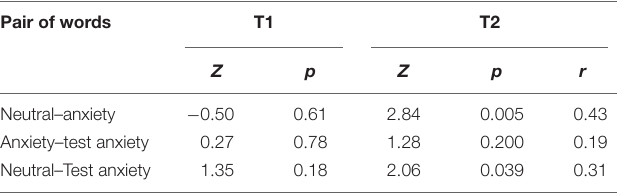
TABLE 2 | Wilcoxon Signed Rank tests ( Z ) and significance levels for differences in reaction times between different pairs at T1 and T2. Pair of words T1